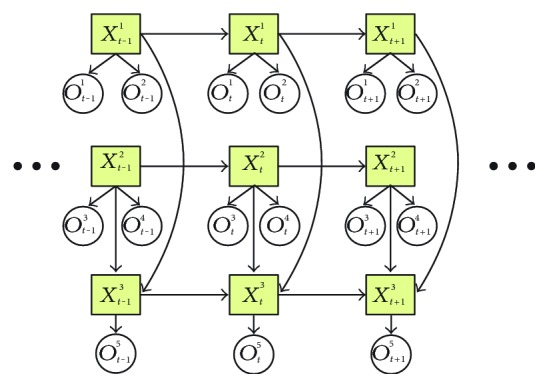
A typical dynamic Bayesian network [101].